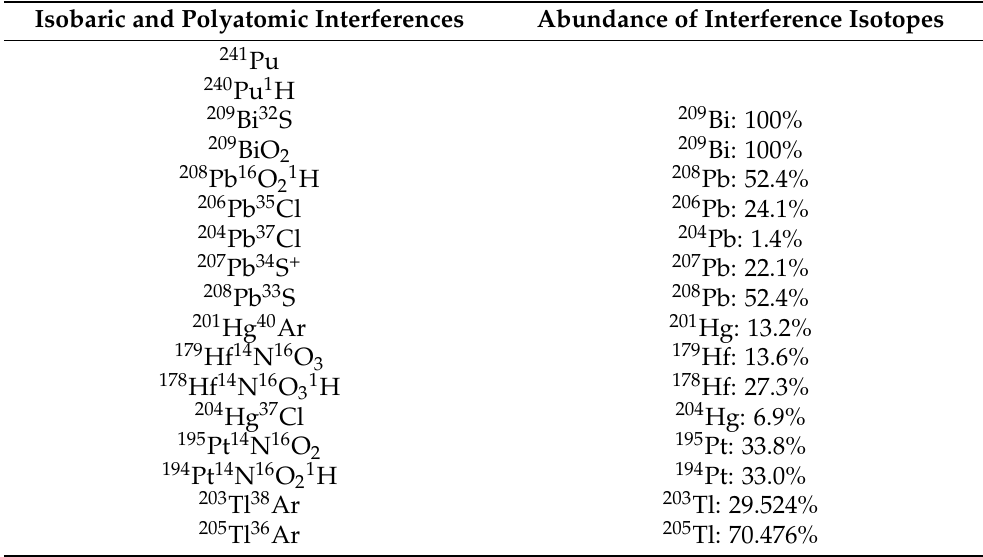
Table 8. Isobaric and polyatomic interferences of 241 Am in ICP-MS measurement. Isobaric and Polyatomic